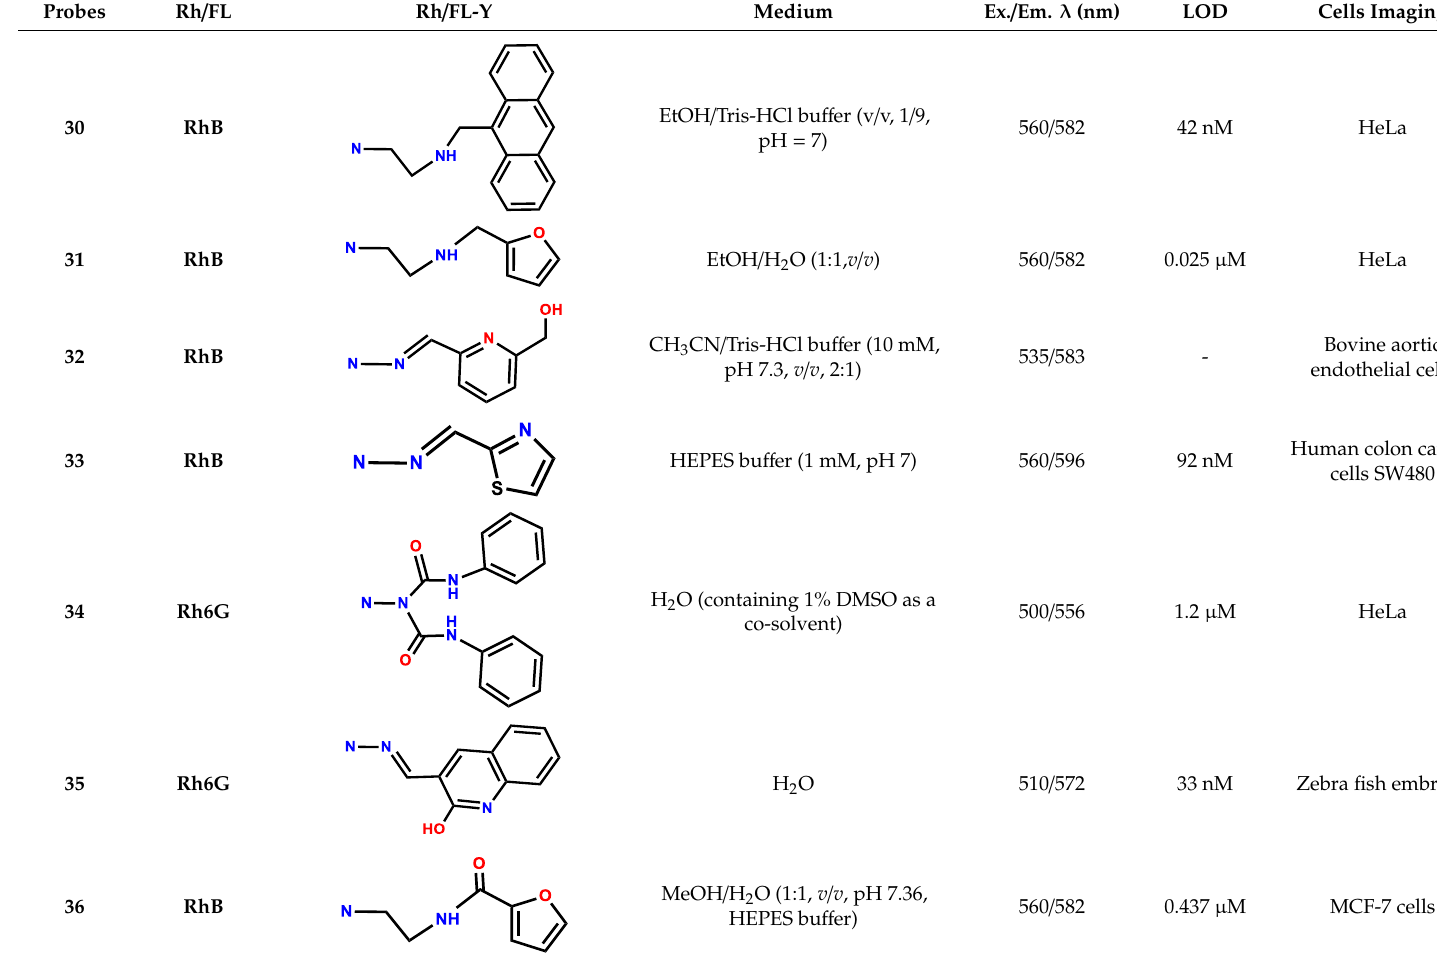
Zebra fish Zebra fish embryos